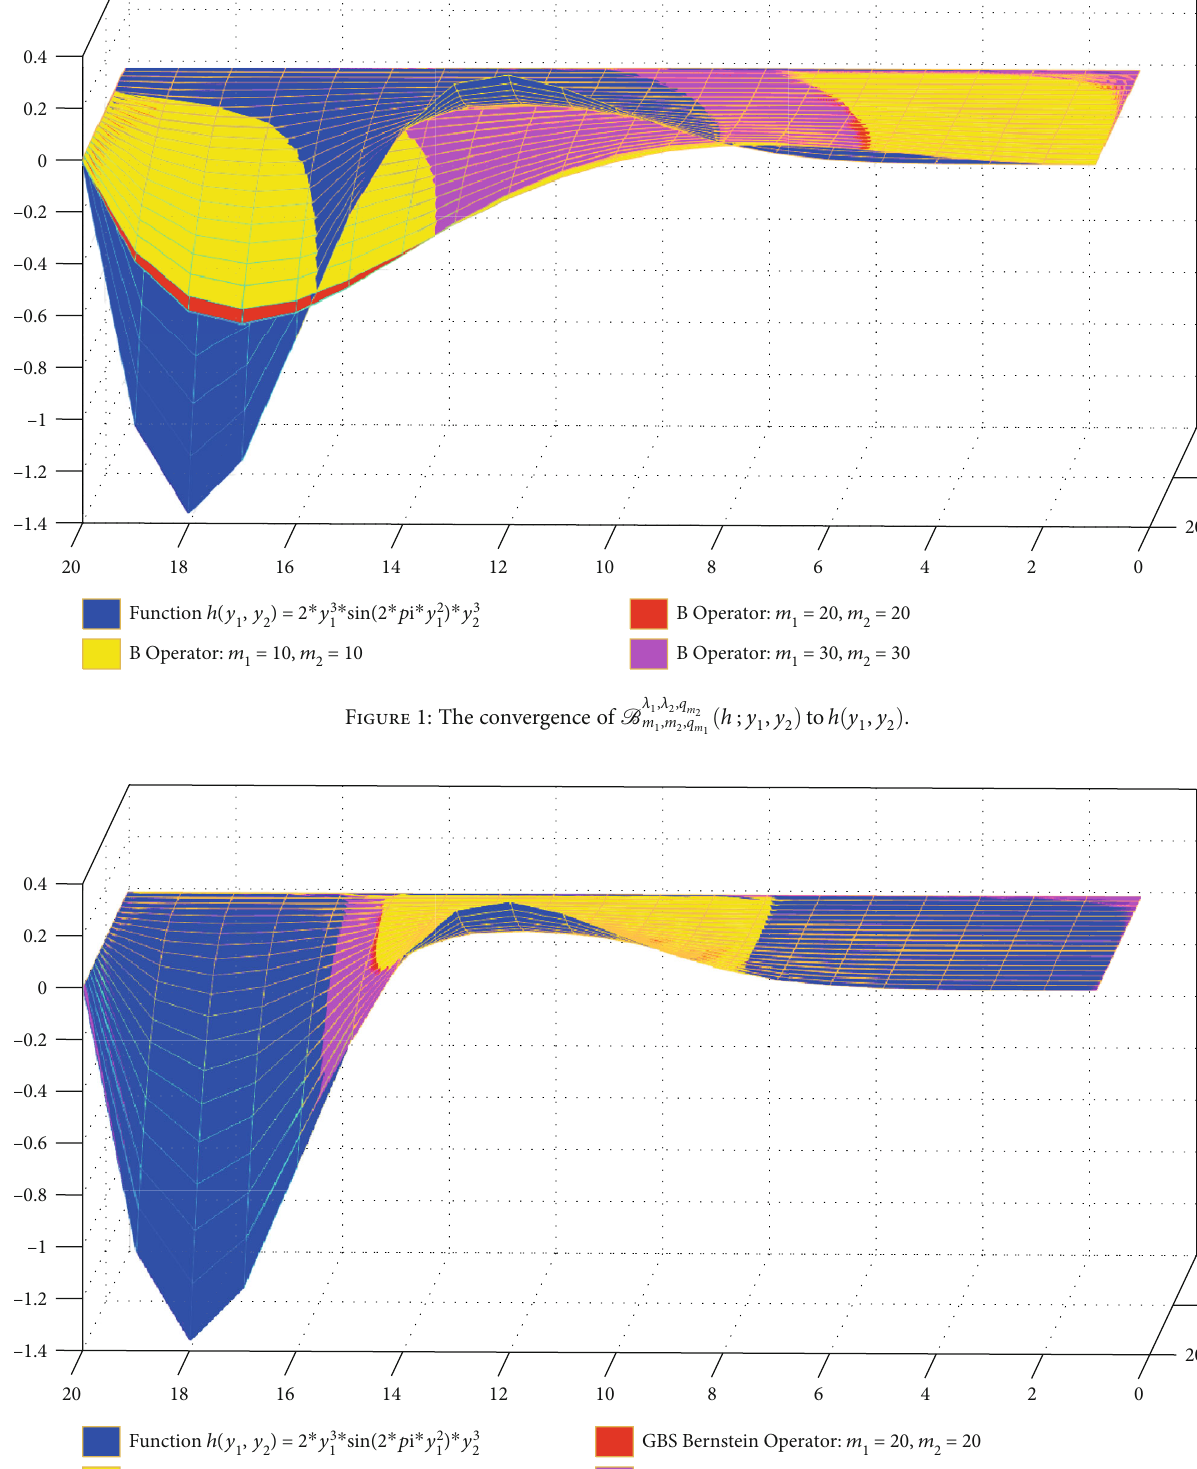
Figure 2: The convergence of B λ 1 , λ 2 , q m 2